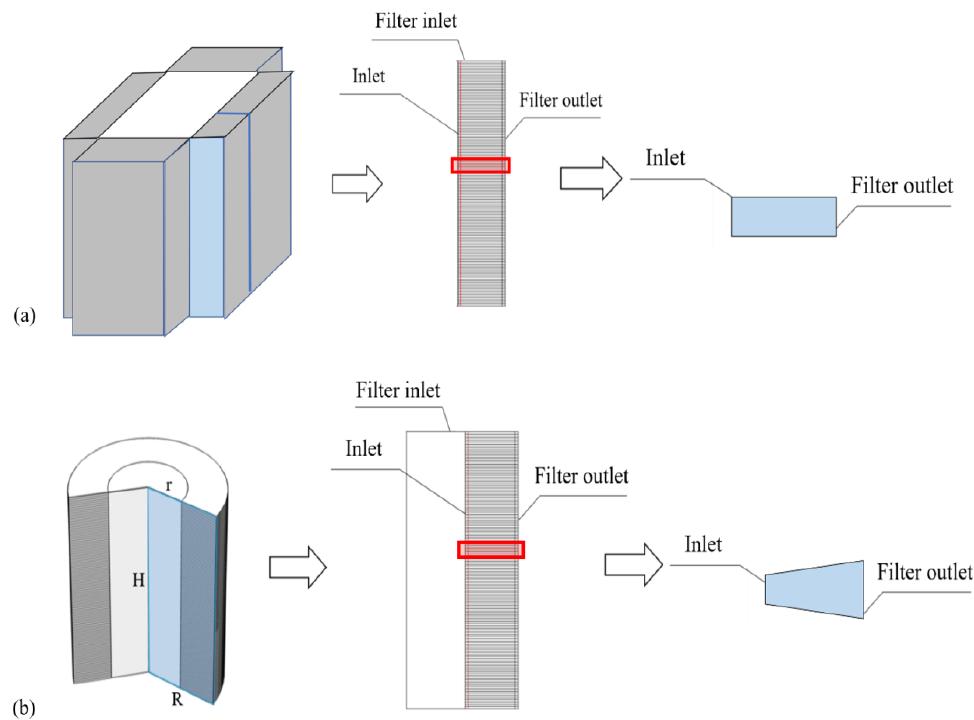
Figure 1. Schematic diagram of the filter structure and airflow direction; ( a ) combined plate micro- electrostatic filter; ( b ) cylindrical micro-electrostatic filter.